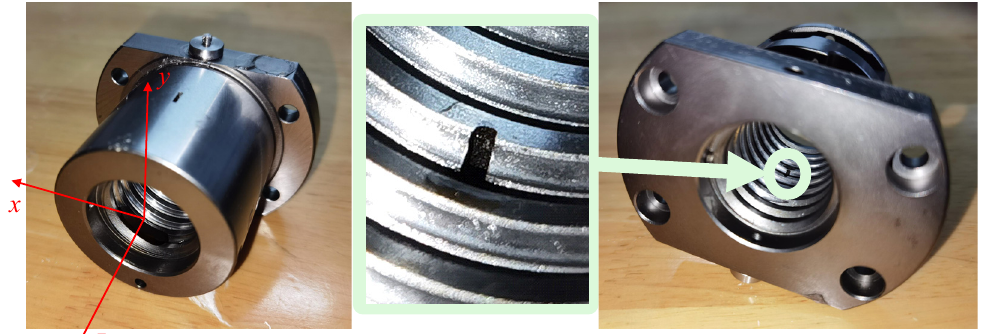
Figure 16. Faulty nut used in the EMA test stand.